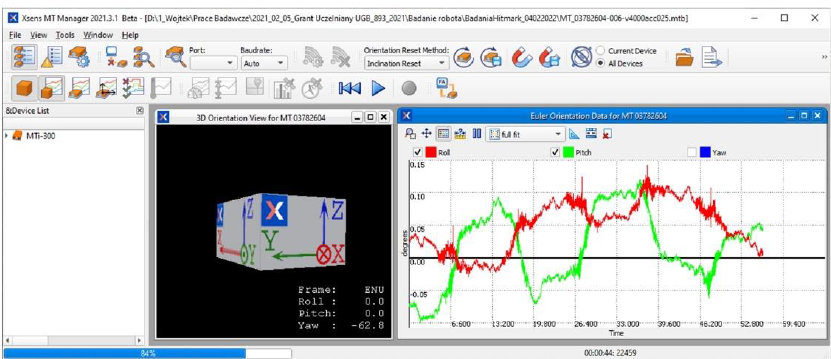
Figure 10. View of MT Manager window.